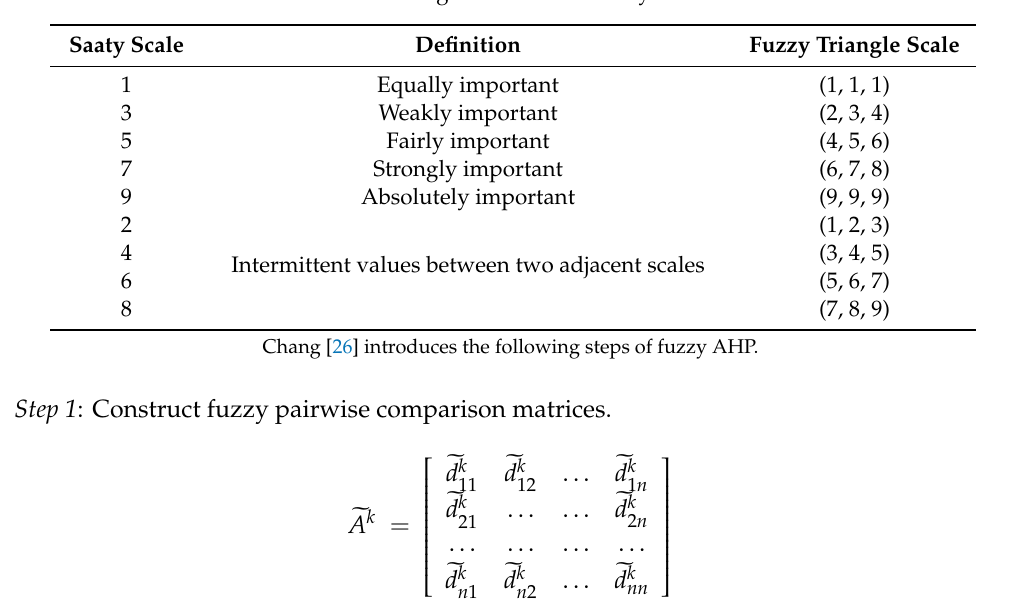
Table 1. Linguistic terms of fuzzy